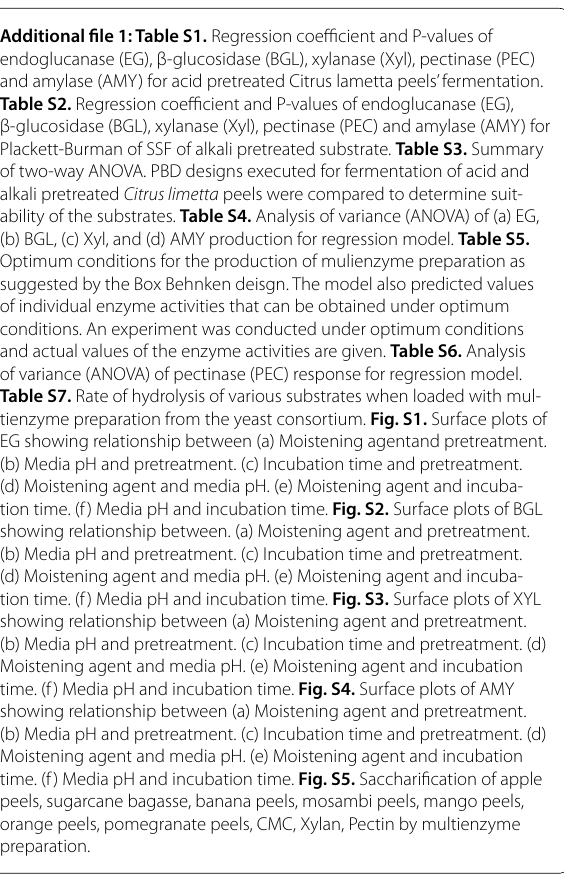
Table S7. Rate of hydrolysis of various substrates when loaded with mul- tienzyme preparation from the yeast consortium. Fig. S1. Surface plots of EG showing relationship between (a) Moistening agentand pretreatment. (b) Media pH and pretreatment. (c) Incubation time and pretreatment. (d) Moistening agent and media pH. (e) Moistening agent and incuba- tion time. (f) Media pH and incubation time. Fig. S2. Surface plots of BGL showing relationship between. (a) Moistening agent and pretreatment. (b) Media pH and pretreatment. (c) Incubation time and pretreatment. (d) Moistening agent and media pH. (e) Moistening agent and incuba- tion time. (f) Media pH and incubation time. Fig. S3. Surface plots of XYL showing relationship between (a) Moistening agent and pretreatment. (b) Media pH and pretreatment. (c) Incubation time and pretreatment. (d) Moistening agent and media pH. (e) Moistening agent and incubation time. (f) Media pH and incubation time. Fig. S4. Surface plots of AMY showing relationship between (a) Moistening agent and pretreatment. (b) Media pH and pretreatment. (c) Incubation time and pretreatment. (d) Moistening agent and media pH. (e) Moistening agent and incubation time. (f) Media pH and incubation time. Fig. S5. Saccharification of